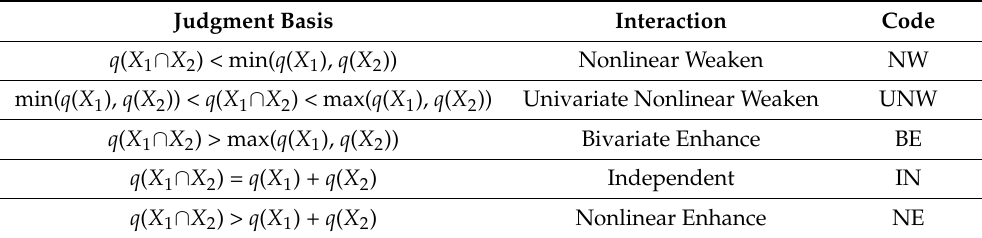
Table 1. Factor interaction